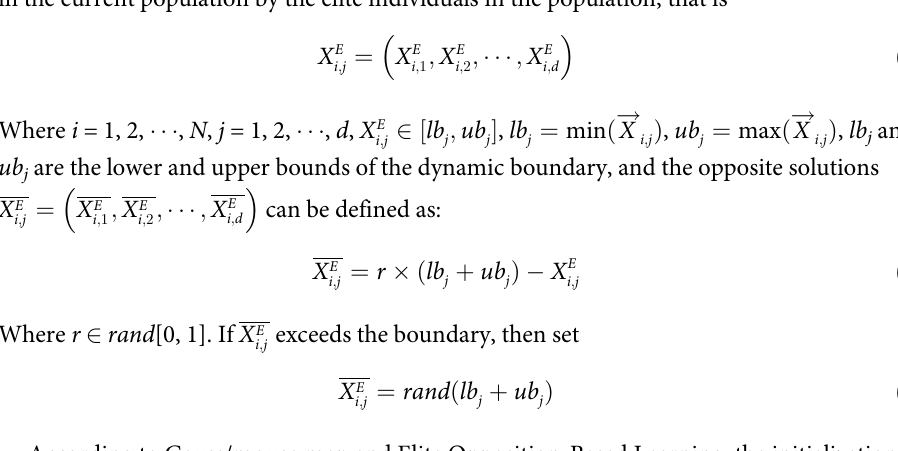
Algorithm 1. Chaotic elite reverse individual.